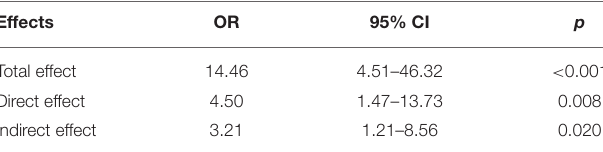
TABLE 3 | Mediation analysis for the association between pain and completed